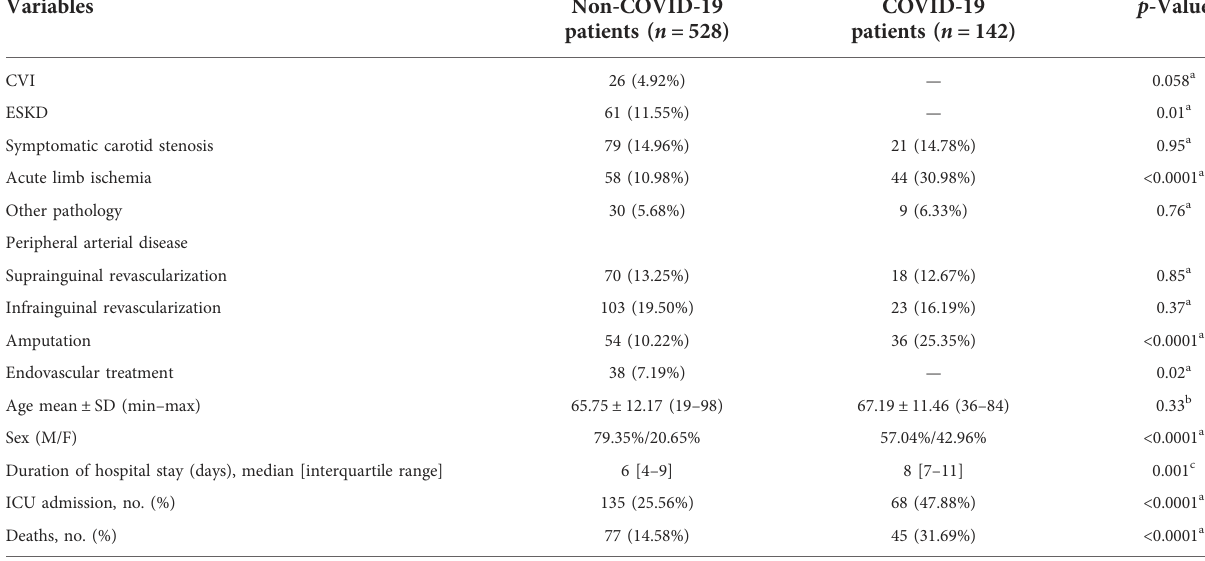
TABLE 2 Characteristics of pandemic period